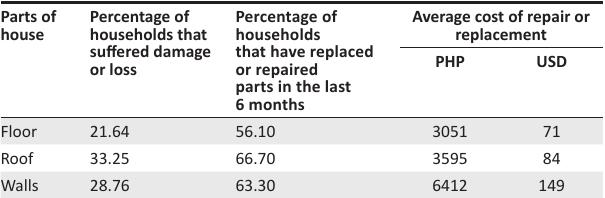
TABLE 5: Damage to